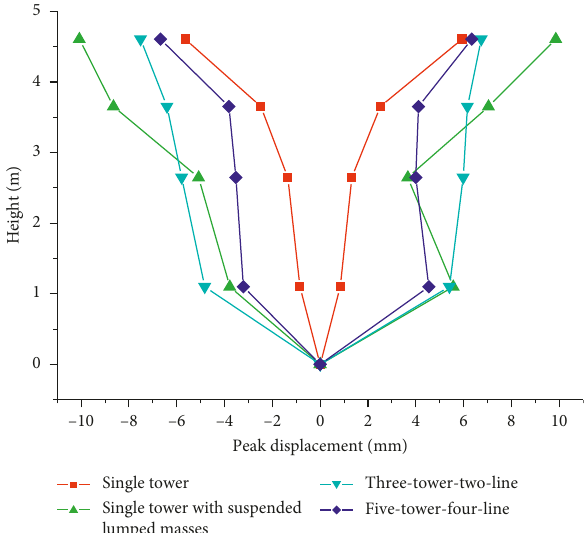
Figure 24: Longitudinal peak displacement responses of the four models under a 0.21g artificial wave. Table 7: Longitudinal peak displacement responses of the middle towers of the four models. Test series Single-tower model